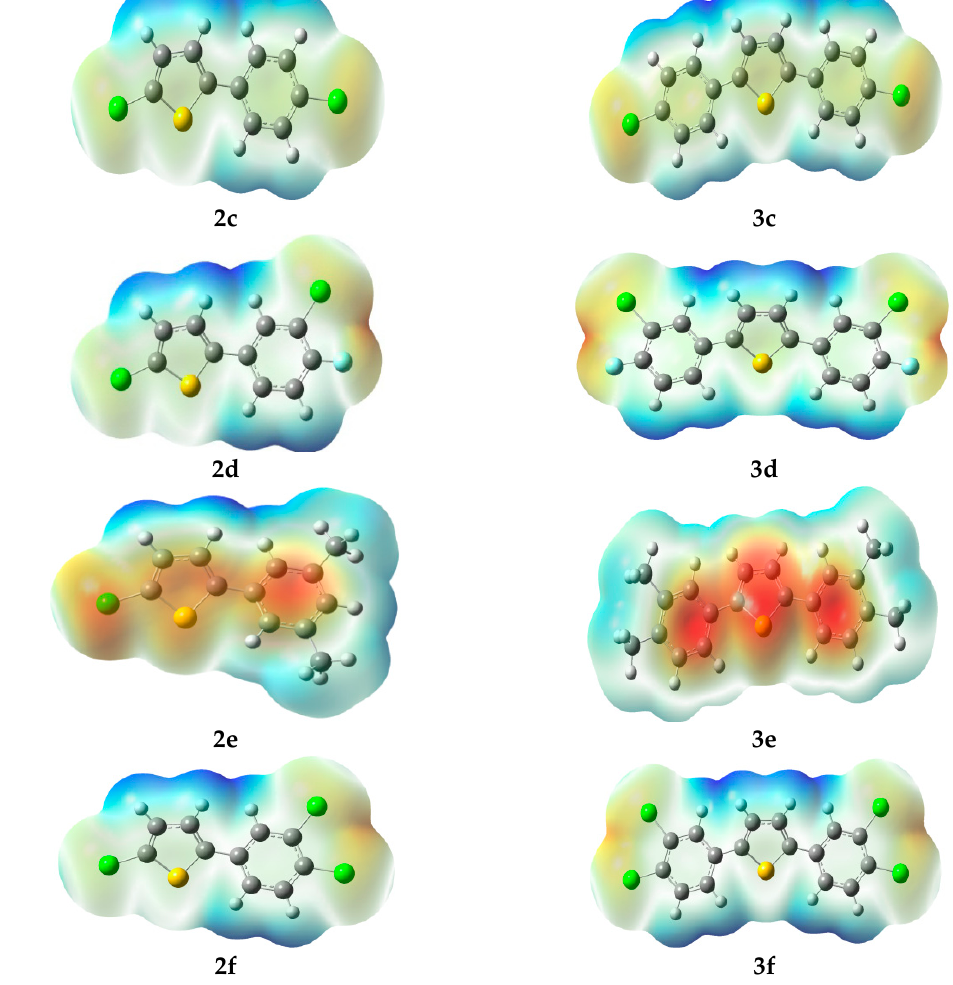
Figure 7. Molecular electrostatic potential (MEP) graphics of mono substituted ( 2a – f ) and di-substituted ( 3a – f ) thiophenes (Red = Intense electron rich site, Yellow = Medium electron rich site, Blue = Electron deficient site, Light green = Almost neutral site, Grey = White = Zero potential).